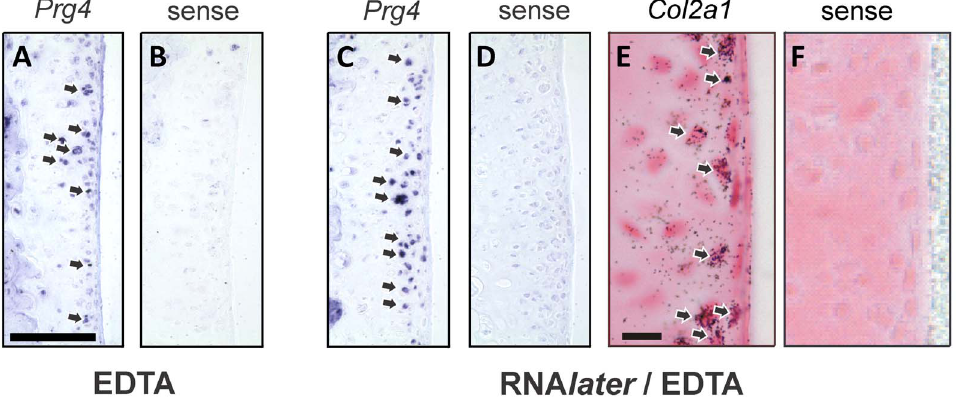
Figure 4. Insitu hybridization for Prg4 and Col2a1 . Cryosections from tibia decalcified with EDTA (A,B) or RNA later /EDTA at pH5.2 (C–F) were hybridized with DIG-labeled Prg4 antisense (A,C) or sense (B,D) RNA probes, and against 35 S-labeled Col2a1 antisense (E) or sense (F) RNA probes for Col2a1 . Arrows show representative regions of target gene mRNA expression. Scale bars=100 m m (A–D), 10 m m (E, F).